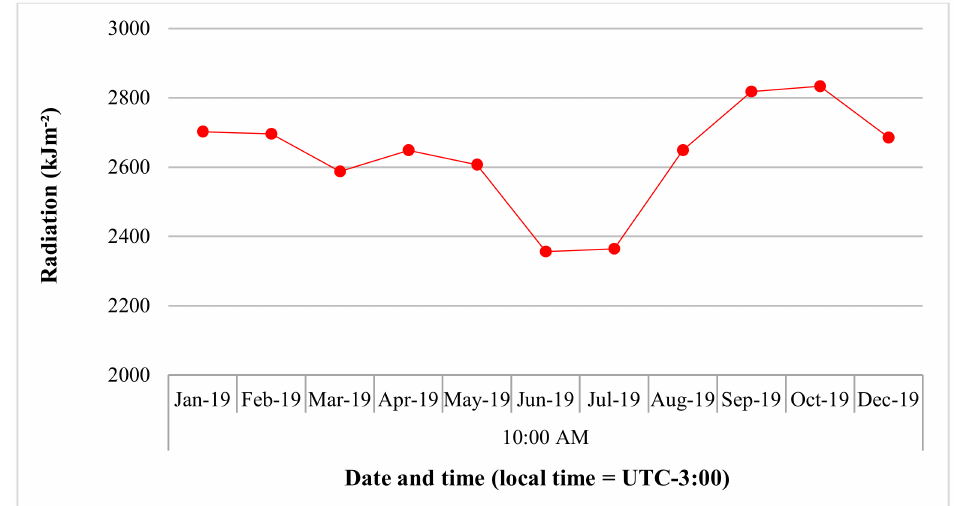
Figure 11. Graph of solar radiation extracted on the days and times of the Sentinel-2 satellite passage, referring to the data used to generate the annual map of chl-a concentration in Castanh ã o reservoir (Figure 7). November radiation was not presented due to lack of data. The data were made available by INMET, at https://portal.inmet.gov.br/ (accessed on 26 February 2020), and extracted from the Morada Nova/CE conventional weather